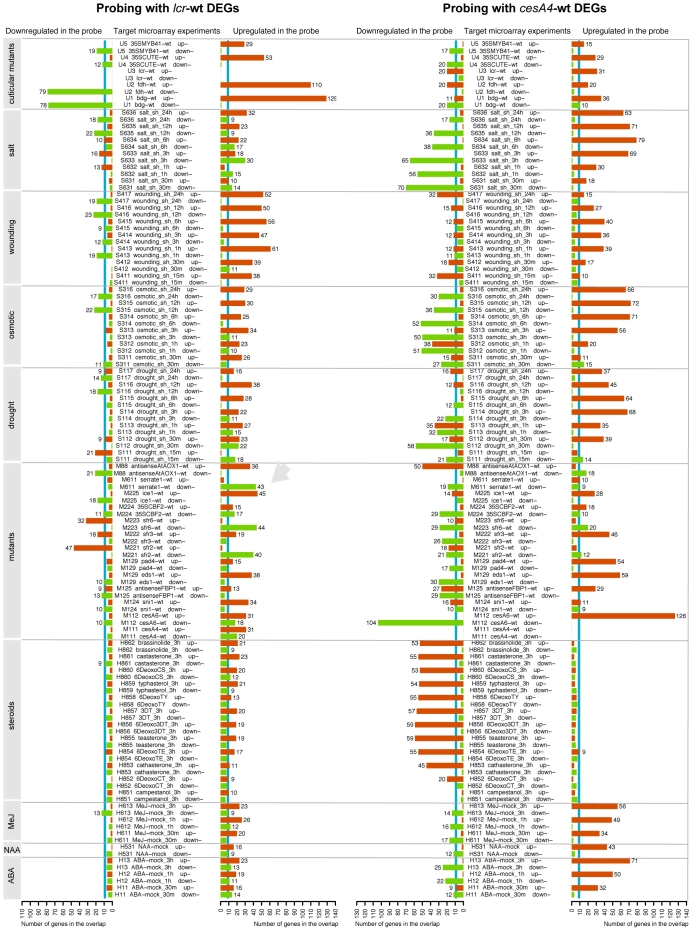
Meta-analysis of differential expressed genes (DEGs) in the cell wall and cuticle-deficient mutants.The bars illustrate gene overlaps for lcr and cesA4/irx5-differentially regulated genes when compared to a subset of DEG lists in the MASTA database (MicroArray overlap Search Tool and Analysis), which contains over 600 microarray contrasts (e.g. mutant vs. wild type, or treatment vs. control comparisons). For the best consistency, the DEGs in MASTA were selected using the Rank Product method [31]. The top 200 upregulated and downregulated genes from each contrast were used for comparisons. The number at each bar indicates the number of genes detected in the overlap between a query and a target DEG list. Arrow points to the overlap between genes upregulated in lcr and those downregulated in se. Shown are only the numbers >9 that correspond to the level of P<7.1×10 −05 (vertical blue lines). The overlap values above this threshold were considered to be statistically significant.